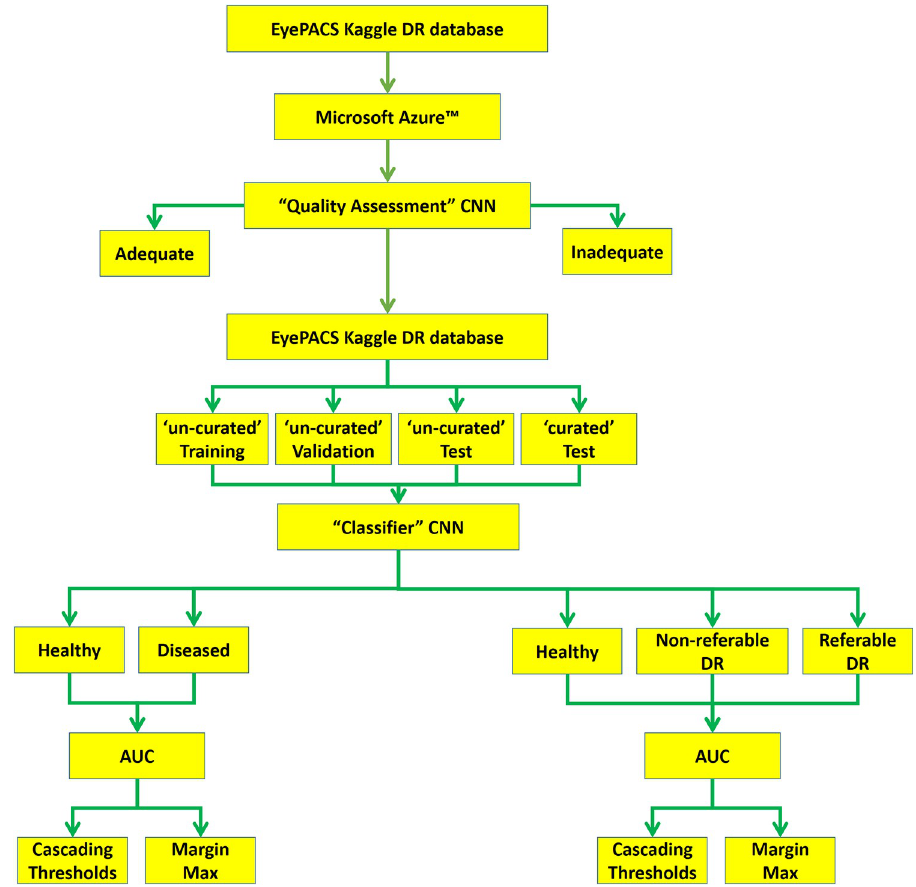
Fig 1. Flowchart of our AI design, implementation and test. The public data attaiment and upload onto the Microsoft Azure cloud platform was the first step. “quality assessment” CNN was trained to identify adequate and inadequate images. the entire public dataset was then devided to training, validation and test sets. The test set was then ‘curated’ by the “quality assessment” CNN. The DRCNN was trained on un-curated data, and then tested on ‘curated’ and ‘un-curated’ data. Its performance was also assessed using 2 or 3 DR labels.